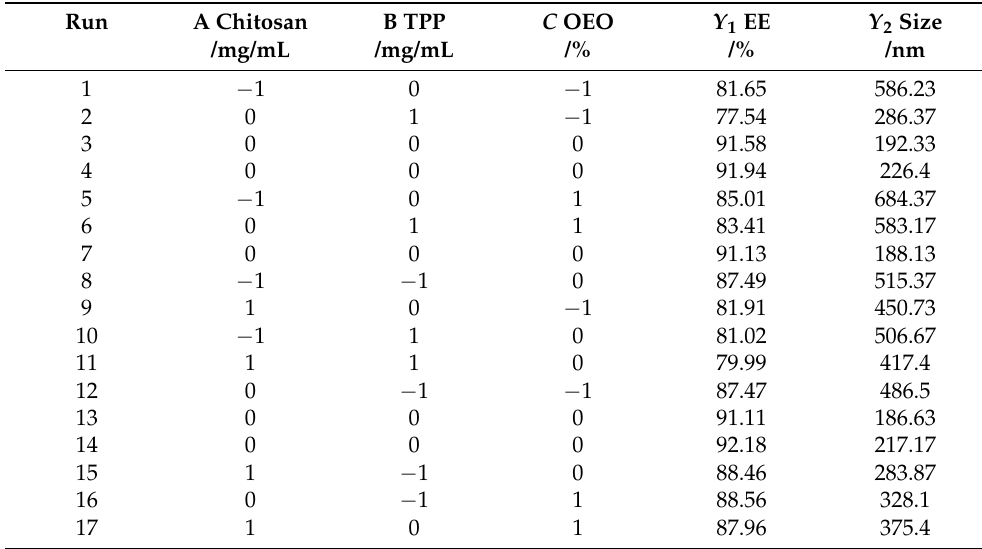
Table 2. Coding factor levels and response values for Box–Behnken